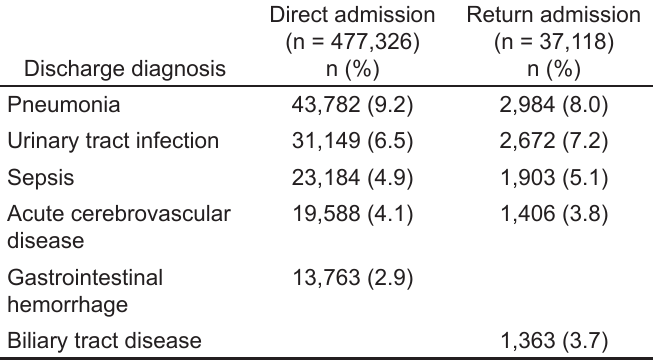
Table 2. Most common hospitalization diagnoses by revisit status.